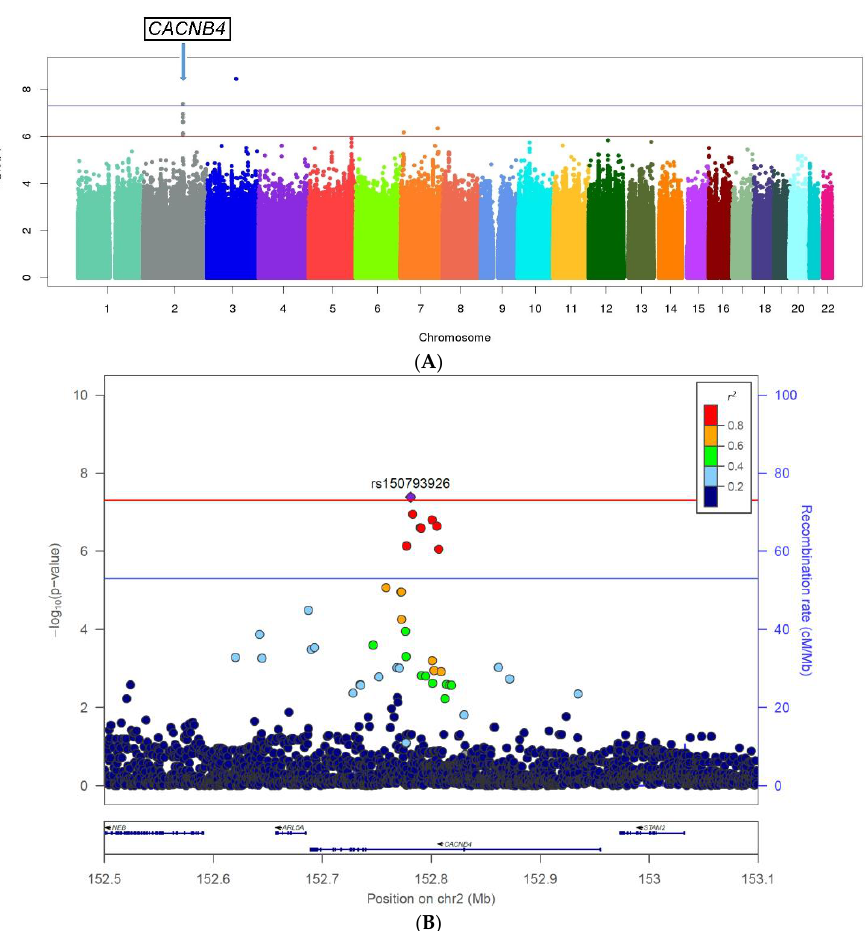
Figure 1. ( A ) Manhattan plots of the genome-wide association results based on imputed data. The x -axis shows the chromosome number, while y -axis shows the −log ( p ). A post genome-wide association study (GWAS) filter was applied including imputation quality measure “info” >0.3, Hardy–Weinberg equilibrium (HWE) p > 1.0 × 10 −6 , minor allele frequencies (MAFs) >1%; ( B ) Regional association plot with linkage disequilibrium (LD) structure for the novel CACNB4 loci. Genomic coordinates are shown on the x -axis, and –log ( p ) is shown on the y -axis to the left. The index genetic variant is shown in purple. The r 2 values of the remaining genetic variants with the index variant are color-coded as indicated by the color bar to the upper right. The genes in this region are indicated at the bottom.